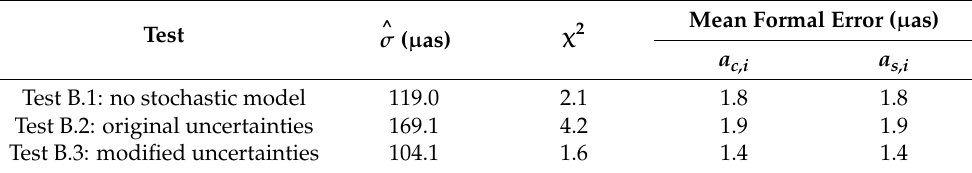
Table 6. Statistical indicators of the solutions obtained using different stochastic models for the fitting of corrections to the IAU 2000A model.